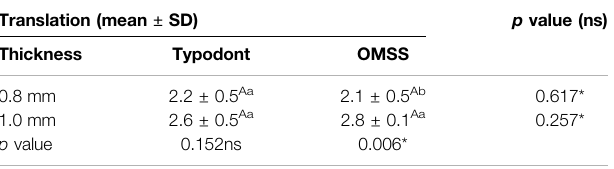
Measurement was done at temperature of 55 ° C on a typodont model and in a custom- made biomechanical system (OMSS). Different uppercase and lowercase superscript letters indicate a statistically signi fi cant difference within the same horizontal row and vertical columns,